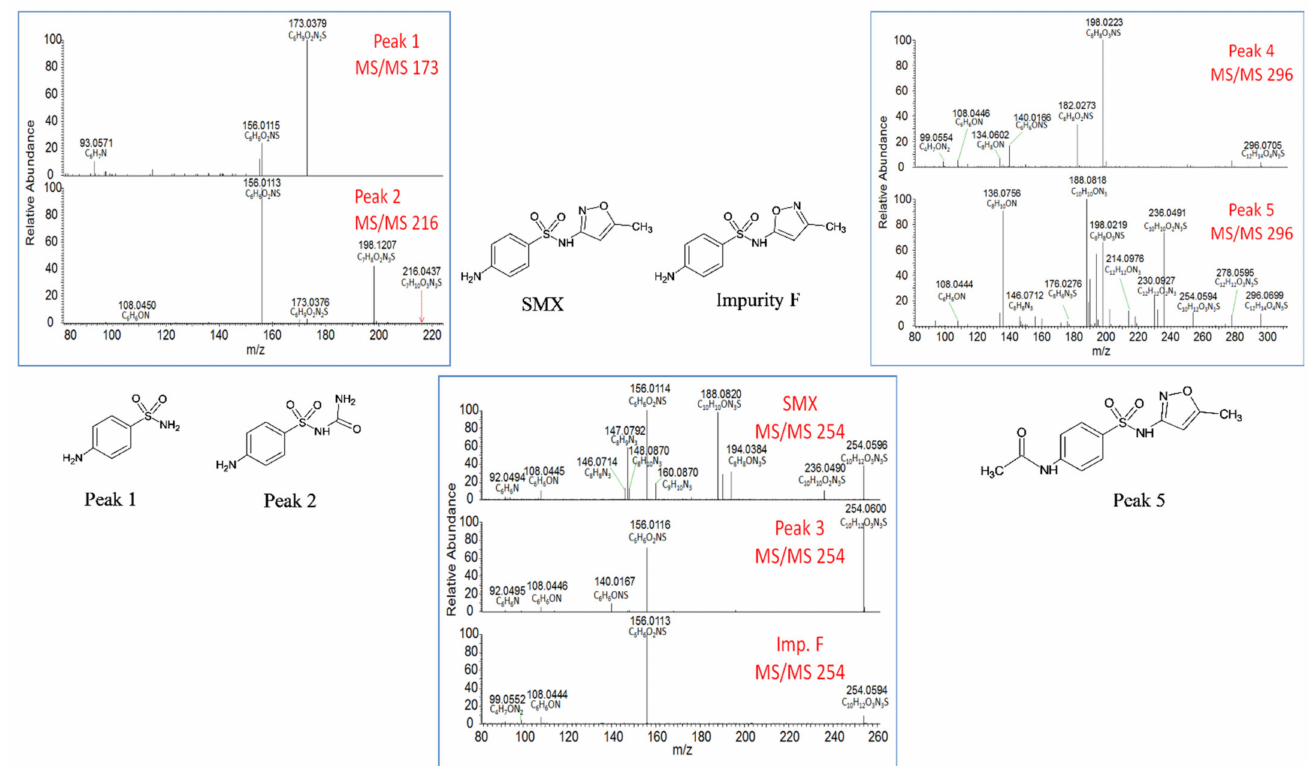
Figure 2. Fragmentation mass spectra of sulfamethoxazole (SMX) degradation compounds.